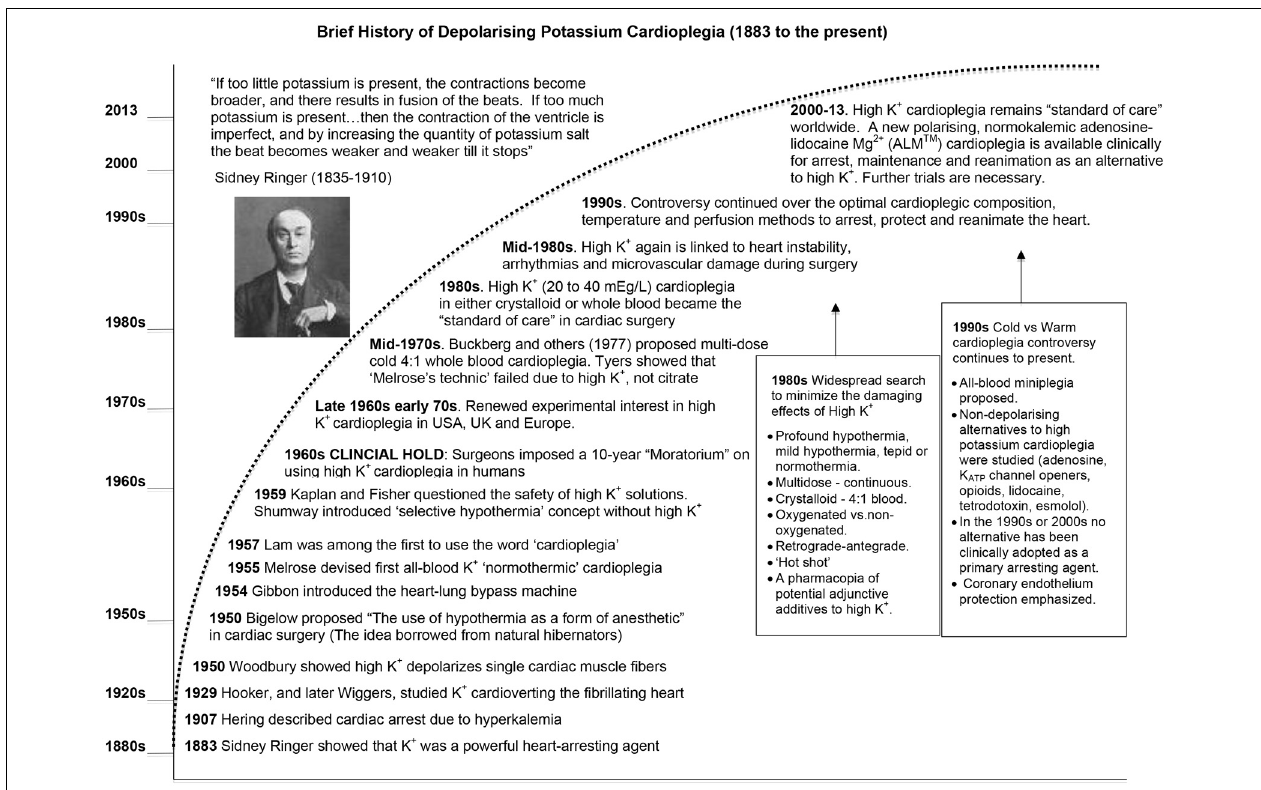
FIGURE 2 | A brief history of the development of potassium cardioplegia from basic science to cardiac surgery (See text for details).